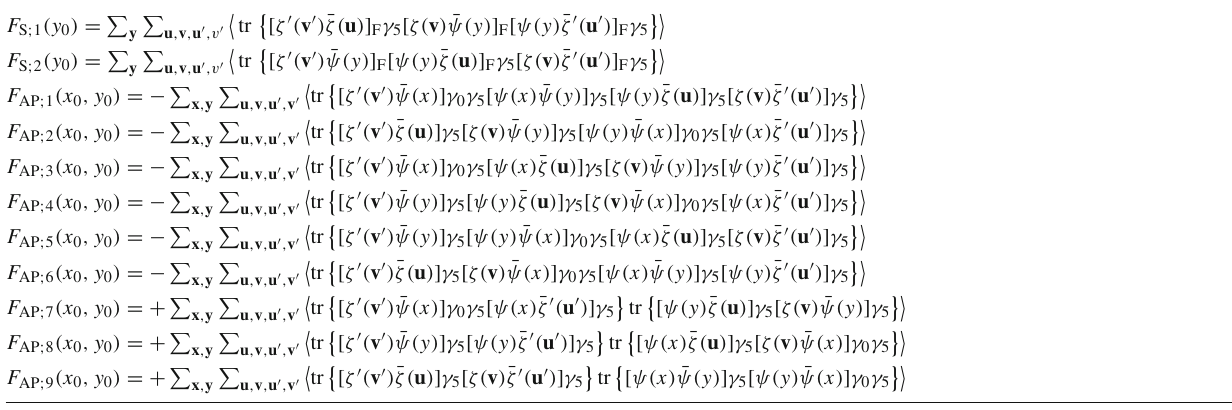
Fig. 1 The trace diagrams contributing to the expectation values of Table 1. The leftmost (rightmost) wall is time-slice x 0 = 0 ( x 0 = T ) with a γ 5 Dirac matrix between circles. The hexagons in the bulk repre- senttheinsertionsofascalaroperator S ( y ) .Theopencirclescorrespond to the boundary fields ζ (at x 0 = 0) and ζ (cid:12) (at x 0 = T ), while the filled